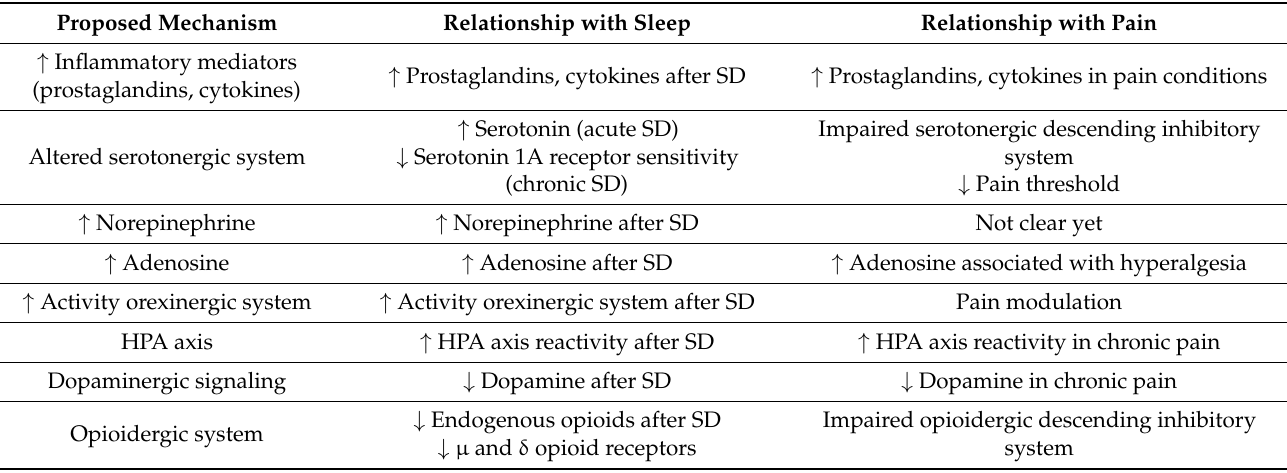
Table 1. Summary of mechanisms to explain the effect of sleep on the sensory component of pain. Proposed